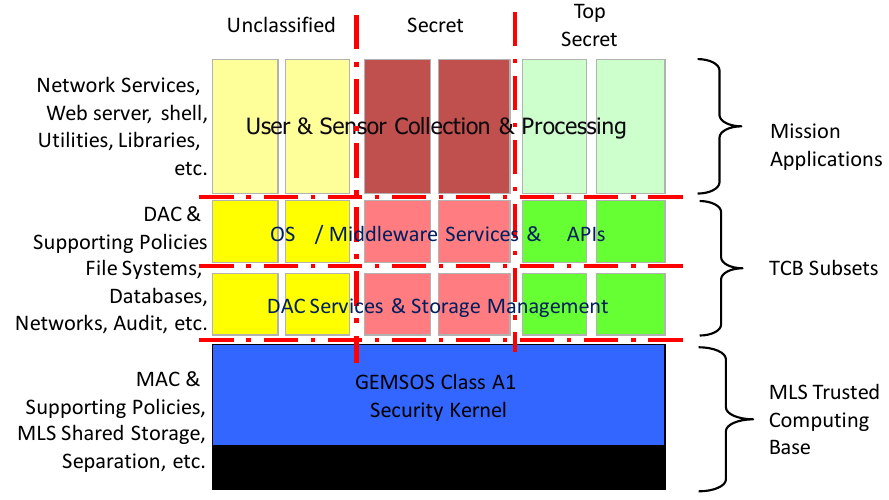
Figure 5. Gemini Multiprocessing Secure Operating System (GEMSOS) generalized Figure 5. composition architecture.